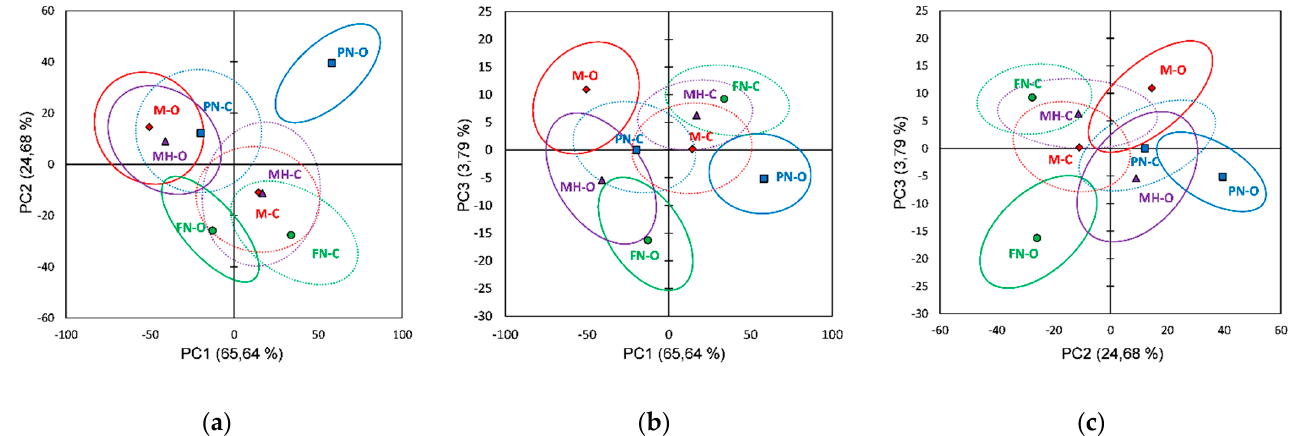
Figure 4. Score plots of the first three principal components derived from FTIR data of the red grape seeds extracts (the